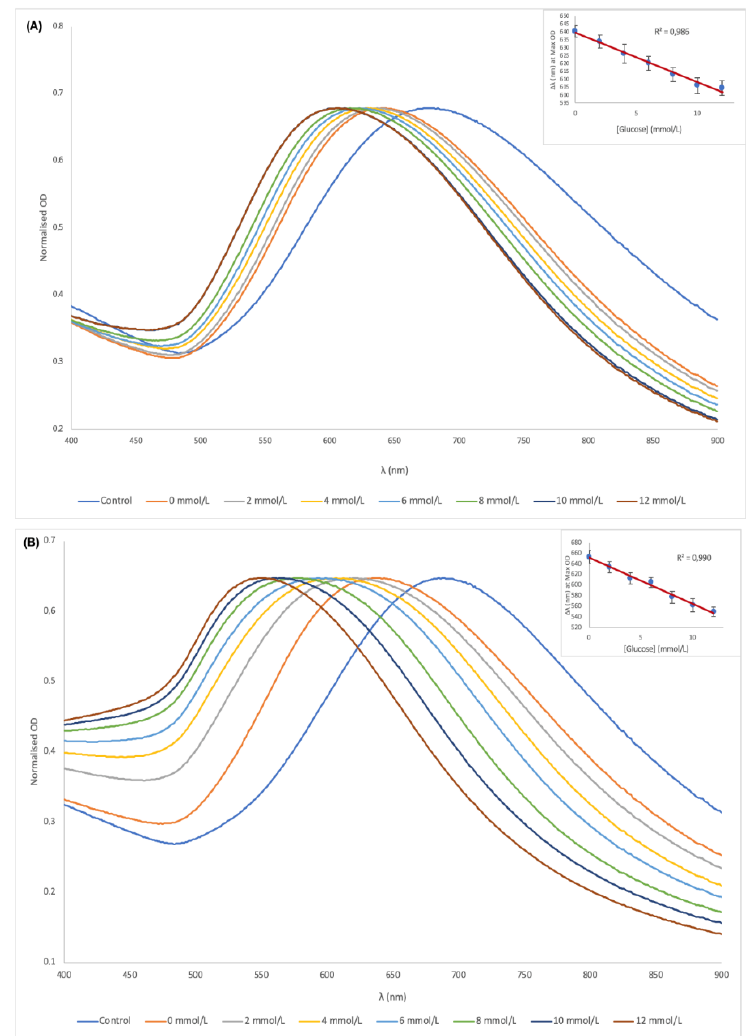
Figure 5. UV-vis spectra of the AuNSs–Cys–GOx bioconjugates and detection solution in the presence of di ff erent concentrations of glucose in serum ( A ) and MES bu ff er ( B ); (Inserts) plot of peak shift vs. glucose concentration for serum and MES bu ff